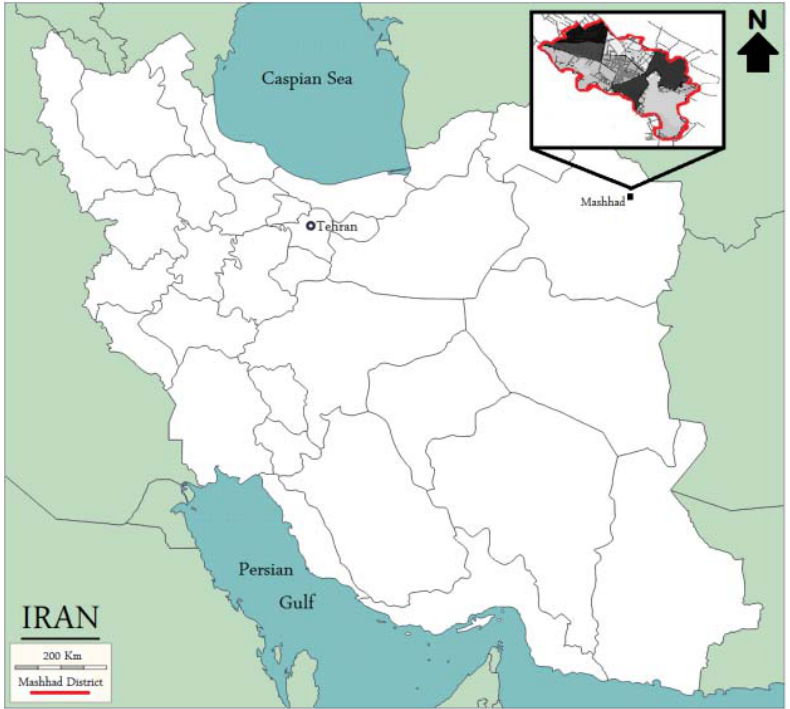
F IGURE 1. Locality of recorded species of Tardigrada in